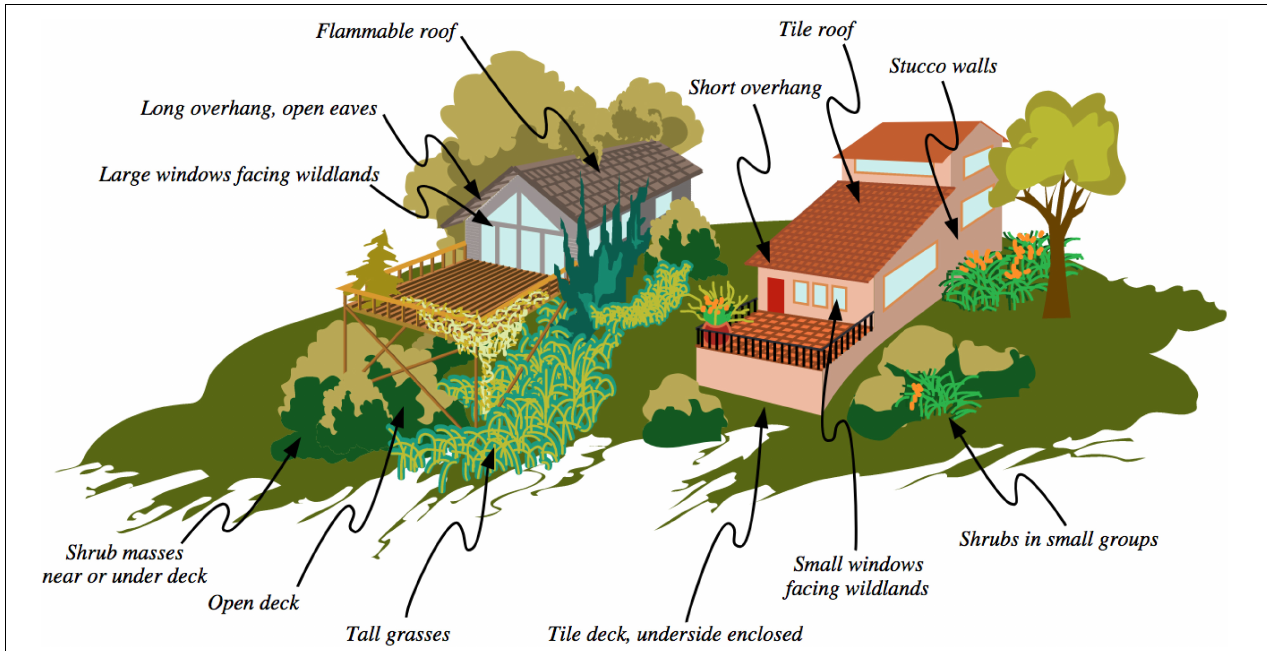
FIGURE 3 | Comparison of homes that are relatively vulnerable (left) versus resistant (right) to ignition by wildfire. (Credit: East Bay Municipal Utility